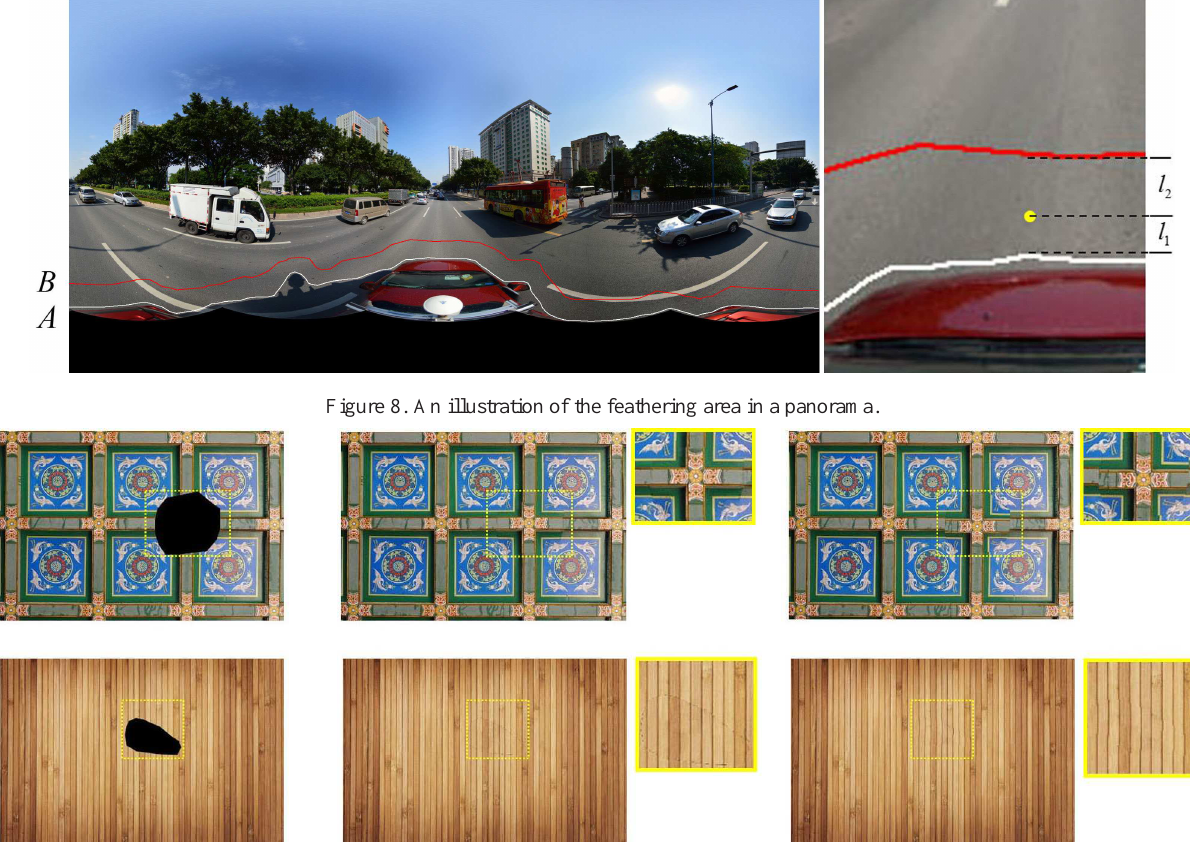
Figure 9. Comparisons between our improved graph cuts optimization and the original method proposed by (He and Sun, 2014): input images with black mask regions to be completed, the completion results by our method and the original one, from left to right.